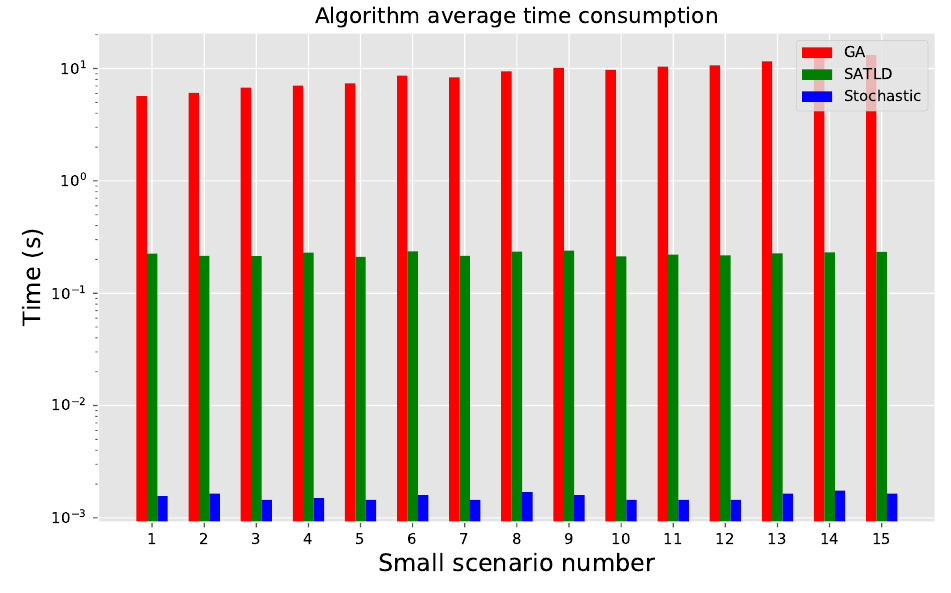
Figure 7. Average time consumption in small scenario.